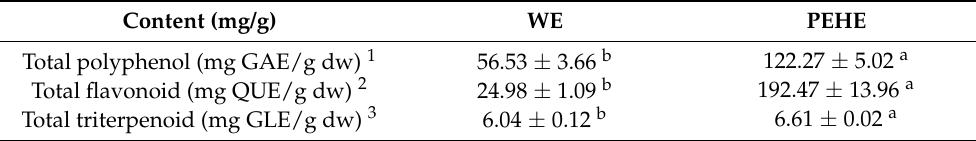
Each value represents the mean ± SD of triplicate experiments. Values with different letters within the same row are significantly different ( p < 0.05). 1,2,3 The total phenol, flavonoid and triterpenoid contents were determined using the calibration curve equations of y = 1.2619x + 0.0055 (r 2 = 0.9945), y = 0.3097x + 0.0466 (r 2 = 0.998) and y = 0.0904x + 0.0104 (r 2 = 0.9995),